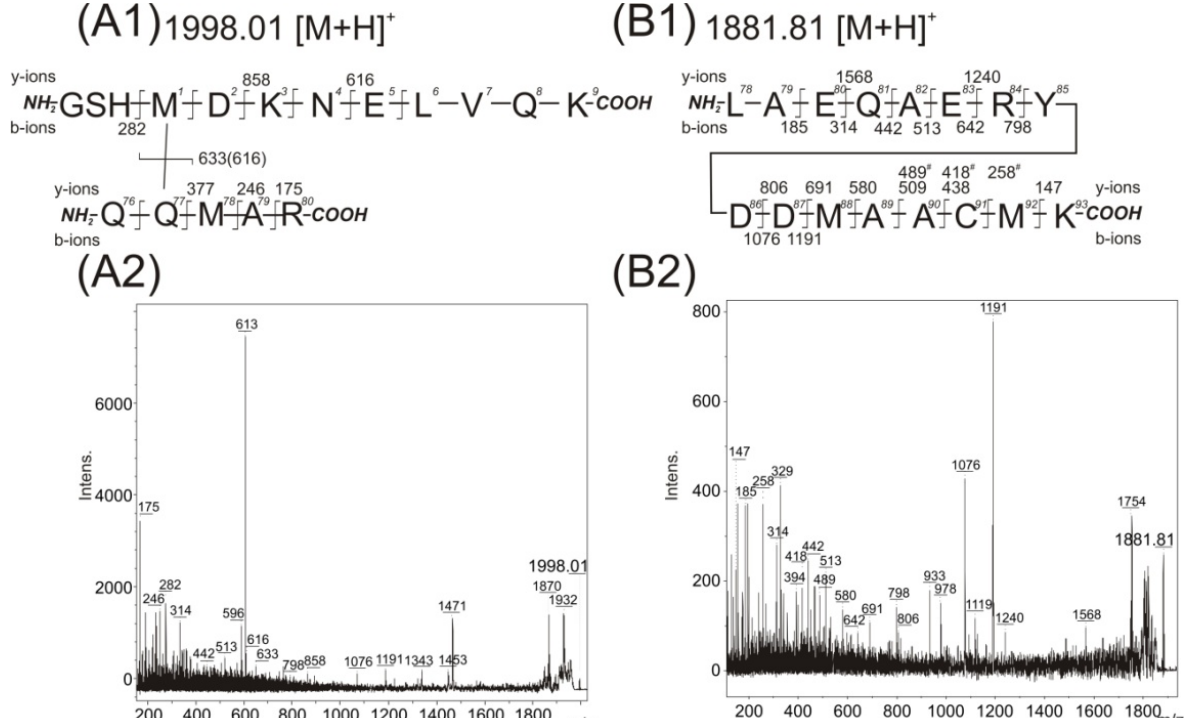
Figure 4. Acquired MS/MS spectra of detected peaks at m / z 1998.01 ( A2 ) and m / z 1881.87 ( B2 ); and structural interpretation of potentially covalently cross-linked Met1–Gln77 ( A1 ) and peptide Leu15–Lys30 ( B1 ). The residue numbering corresponds with the full-length sequence of the 14-3-3 ζ (UniProtKB database accession number P63104 [10]). Intens. means absolute